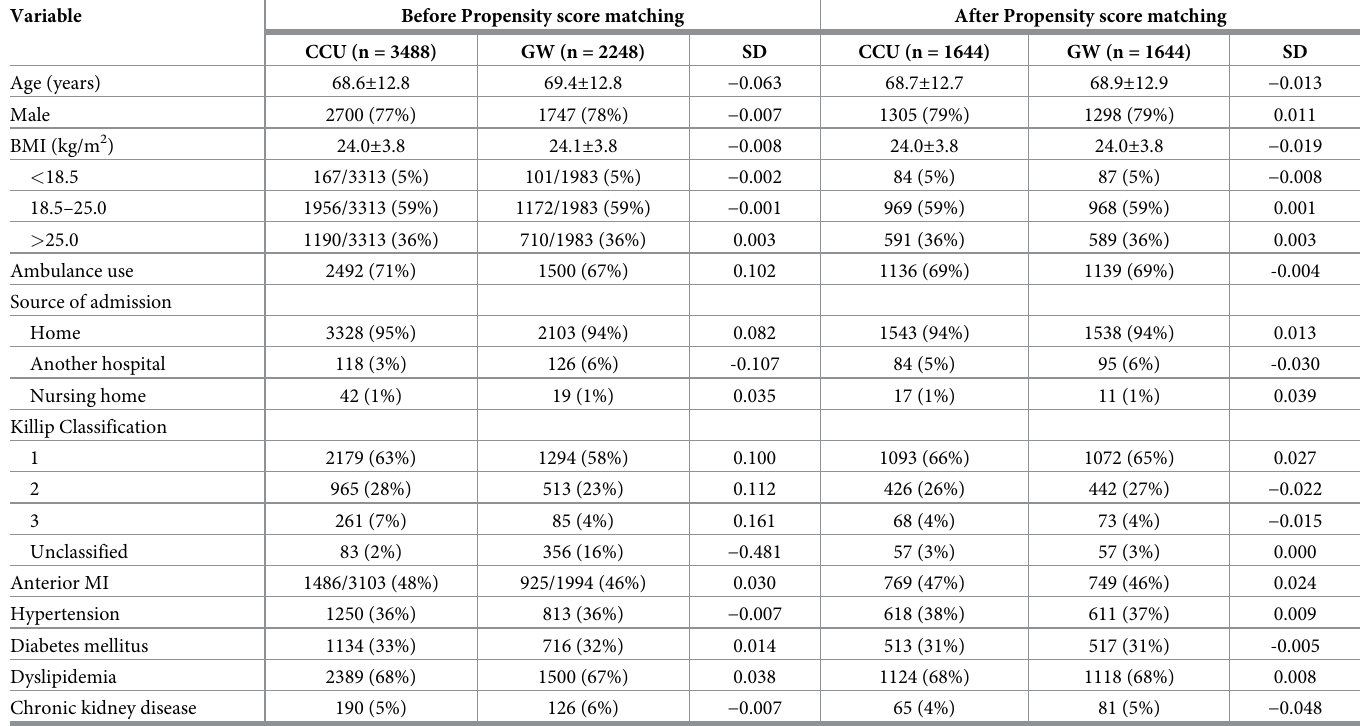
Table 1. Patient characteristics (before and after propensity score-matching).